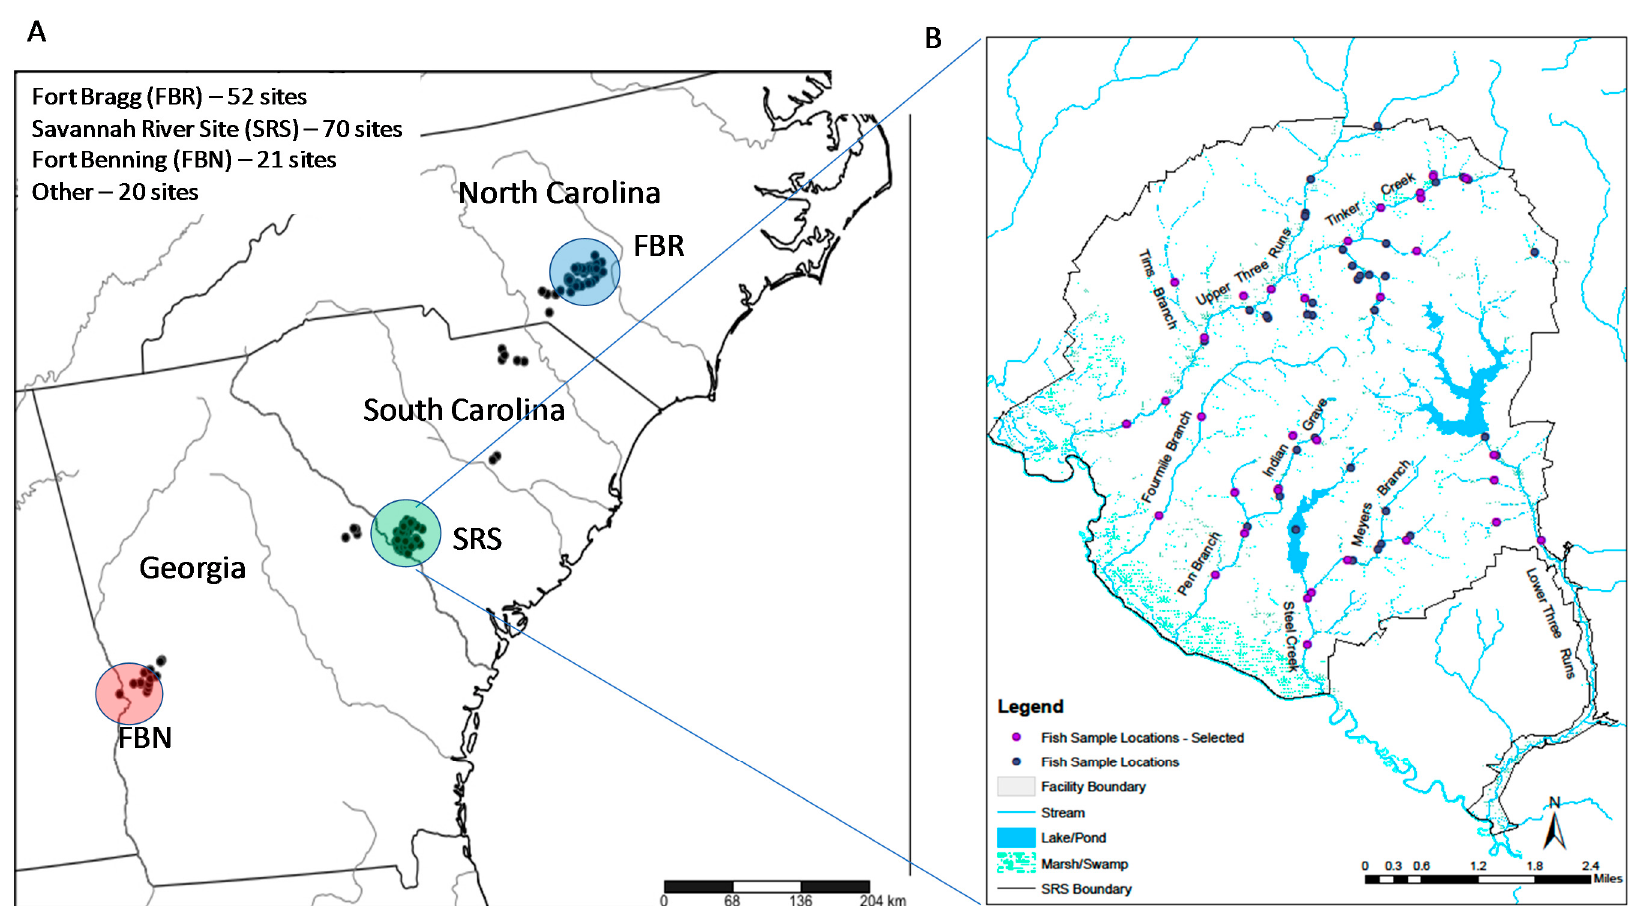
Figure 1. Electrofishing sample sites in the Sand Hills ecoregion ( A ) including sample sites located on the Savannah River Site ( B ). “Selected” sites in ( B ) are used in the stratified design described in the text. Site in the center of the reservoir in ( B ) in was sampled before the reservoir was constructed.